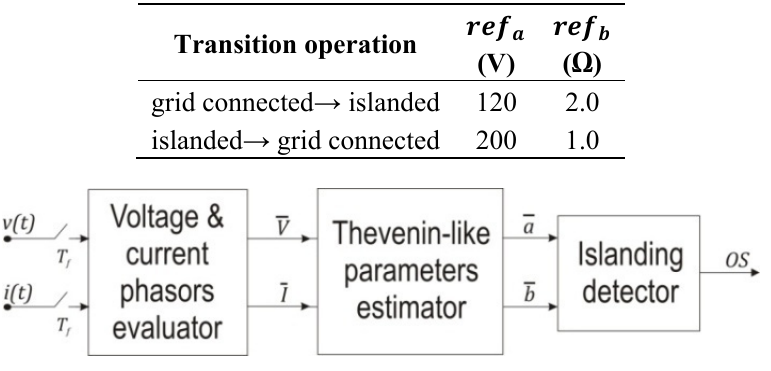
Figure 2. Block diagram of the